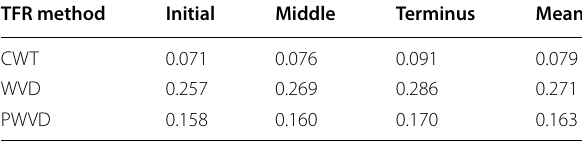
Table 4 Time consumption of different TFR generation